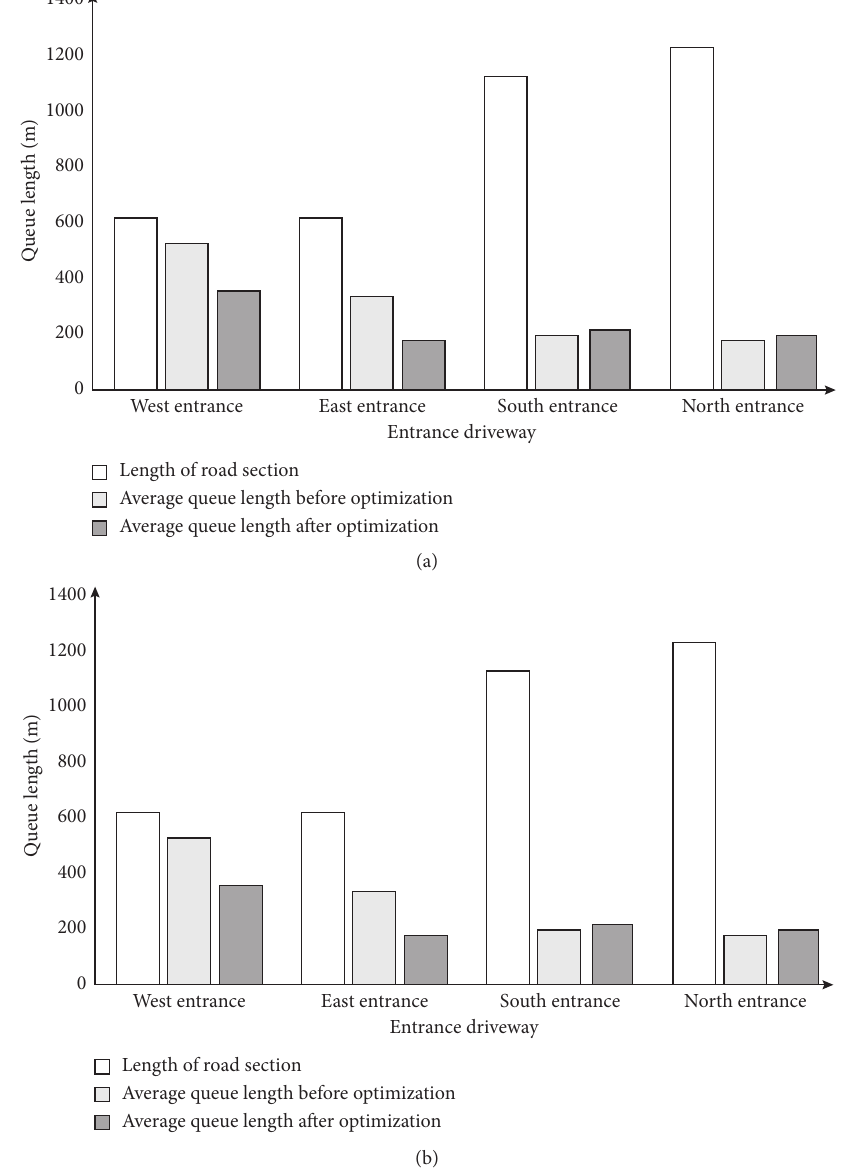
Figure 8: Comparison of traffic performance index before and after the signal control optimization at the intersection. (a) Average delay per vehicle. (b) Average queue